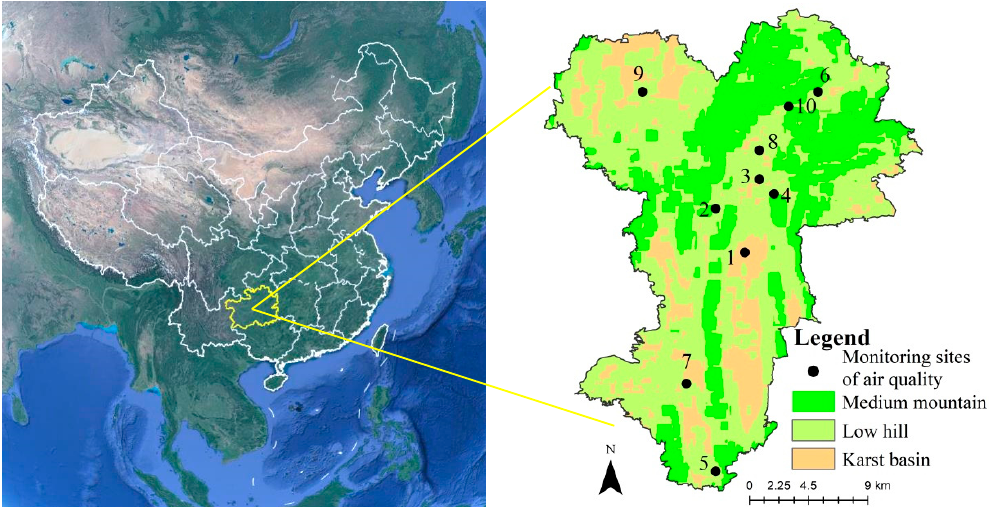
Figure 1. Geographical location and landform of Guiyang City and the distribution of air quality stations (based on Google Earth).